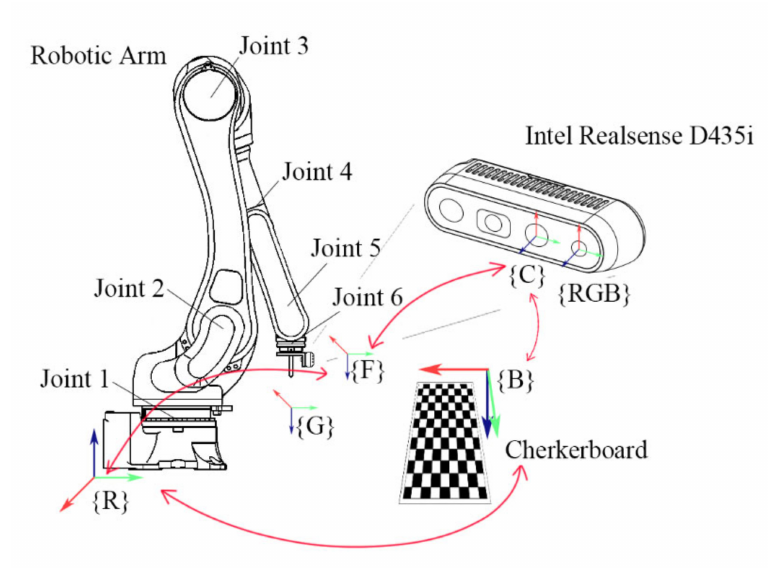
Figure 3. Coordinate transformation chain in the eye-in-hand